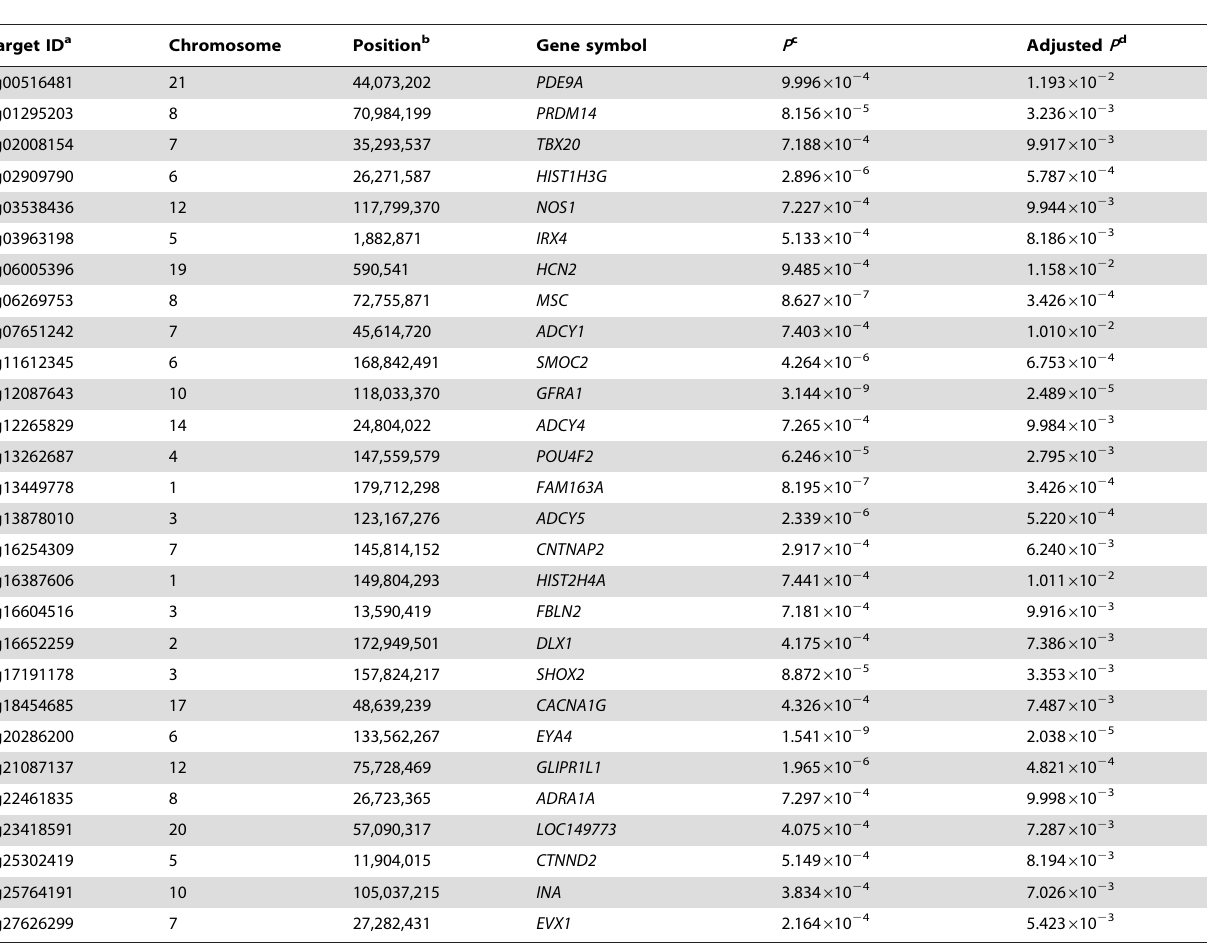
Table 1. The 28 probes for which the average b -value in N samples ( b N ) was higher in recurrence-positive patients than in recurrence-negative patients, for which the average b -value in C samples ( b C ) was less than 0.2, and for which the average b -value in T samples minus that in corresponding N samples ( Db T–N ) was more than